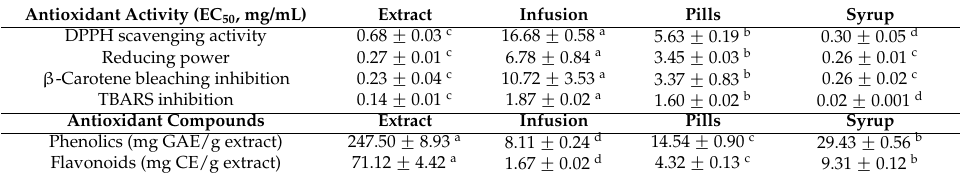
Table 2. Antioxidant properties of T. impetigosa extracts and dietary supplements (Mean ˘ SD). Antioxidant Activity (EC 50 ,